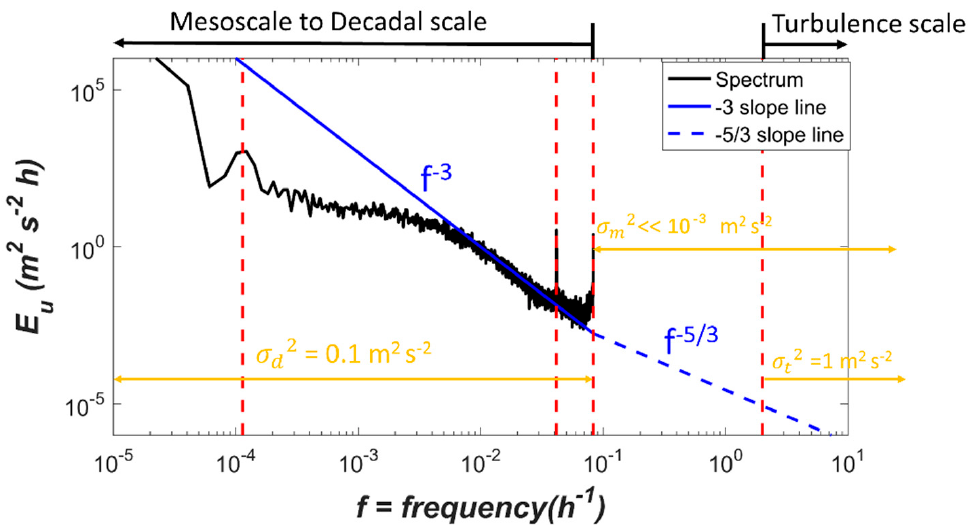
Figure 9. Energy spectrum of global average 6-hourly wind speed. The spectrum is extrapolated from 12 h to a turbulence scale (seconds) via Kolmogorov’s –5/3 power law (f –5/3 , blue dashed line). The resolved spectrum has an exponent of –3 from multi-day to 12 h (f –3 , blue solid line) consistent with an enstrophy cascade in a quasi-geostrophic flow. The dashed vertical lines (right to left) indicate frequencies corresponding to the following timescales: sub-hour (=0.5 h), diurnal (=12 h), daily (=24 h), and annual (=8760 h), respectively. The σ d2 , σ m2 , and σ t2 refer to the variance at large (mesoscale to decadal), intermediate (12 h to turbulence), and small (turbulence) scales, respectively.